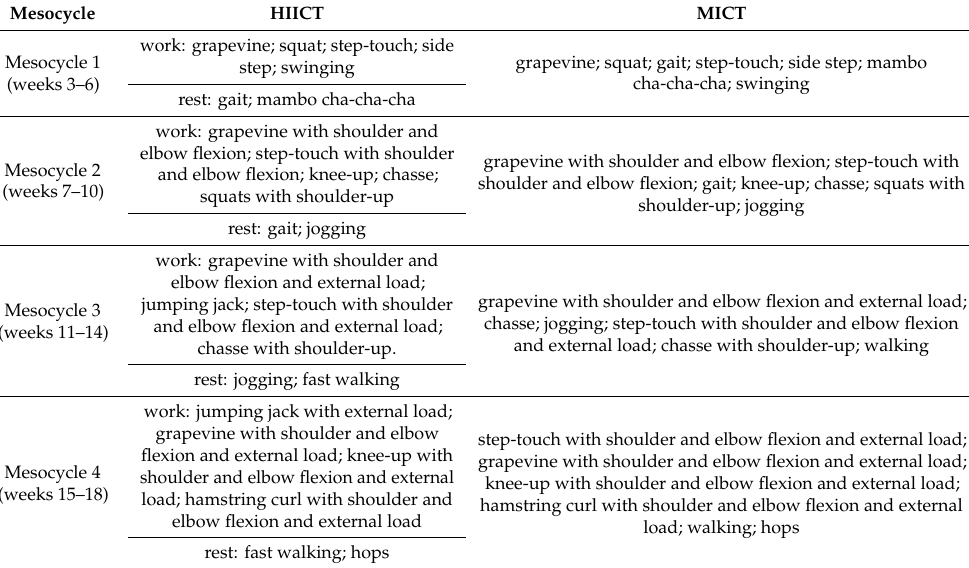
Table 2. Exercise examples for HIICT and MICT groups in each